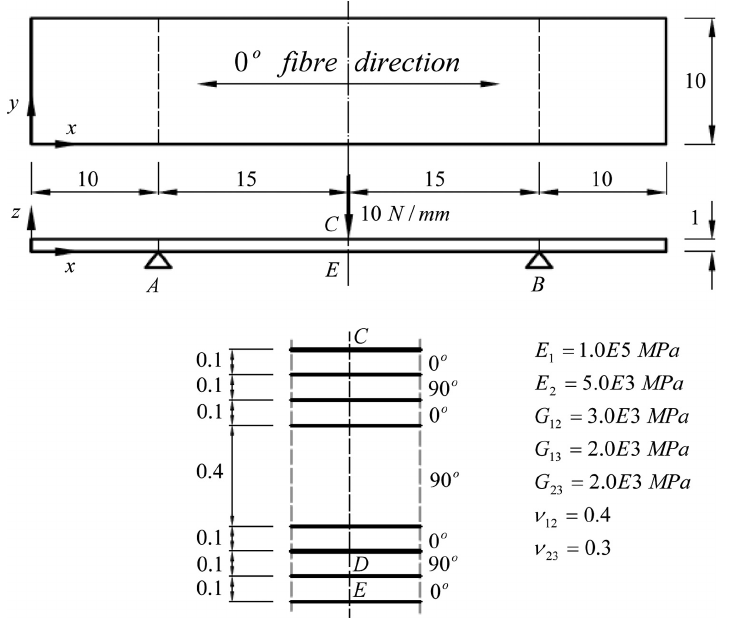
Fig. 6. Simply supported laminated beam subjected to central line load with material properties [13].